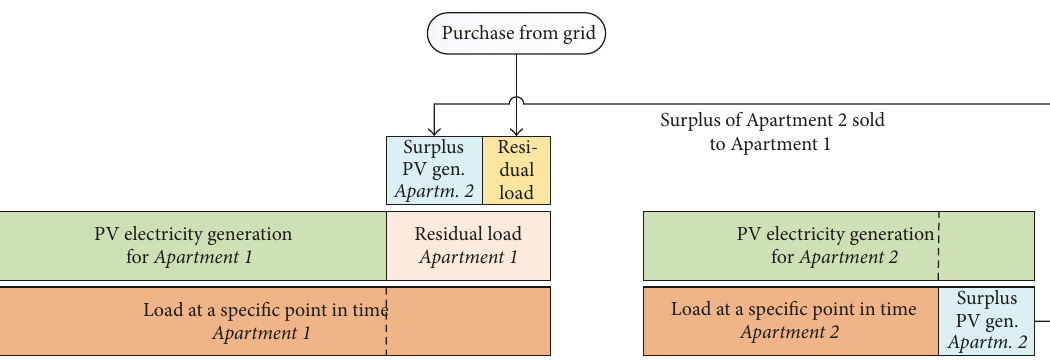
Figure 27: Dynamic allocation of PV generation: example of two apartments.